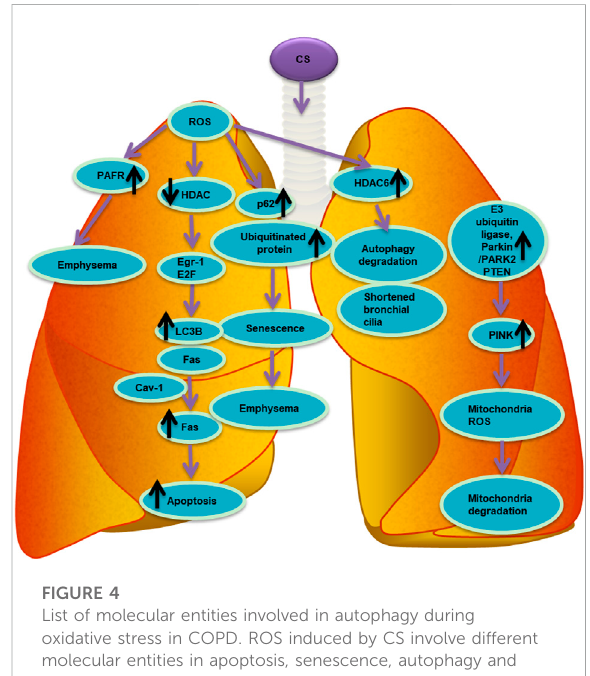
FIGURE 4 List of molecular entities involved in autophagy during oxidative stress in COPD. ROS induced by CS involve different molecular entities in apoptosis, senescence, autophagy and mitophagy in the pathogenesis of chronic obstructive pulmonary disease